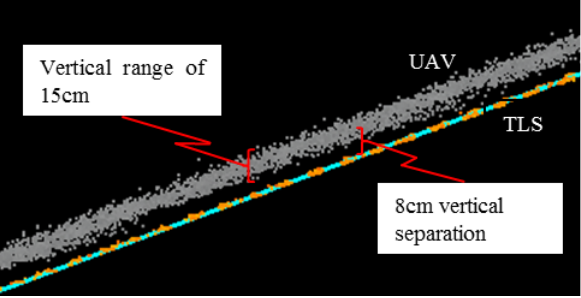
Figure 5. Building 1. UAV point cloud noise and vertical bias compared to TLS. The roof faces of building 2 (planes 4-8) were oriented NW-SE and NE-SW (Figure 6).